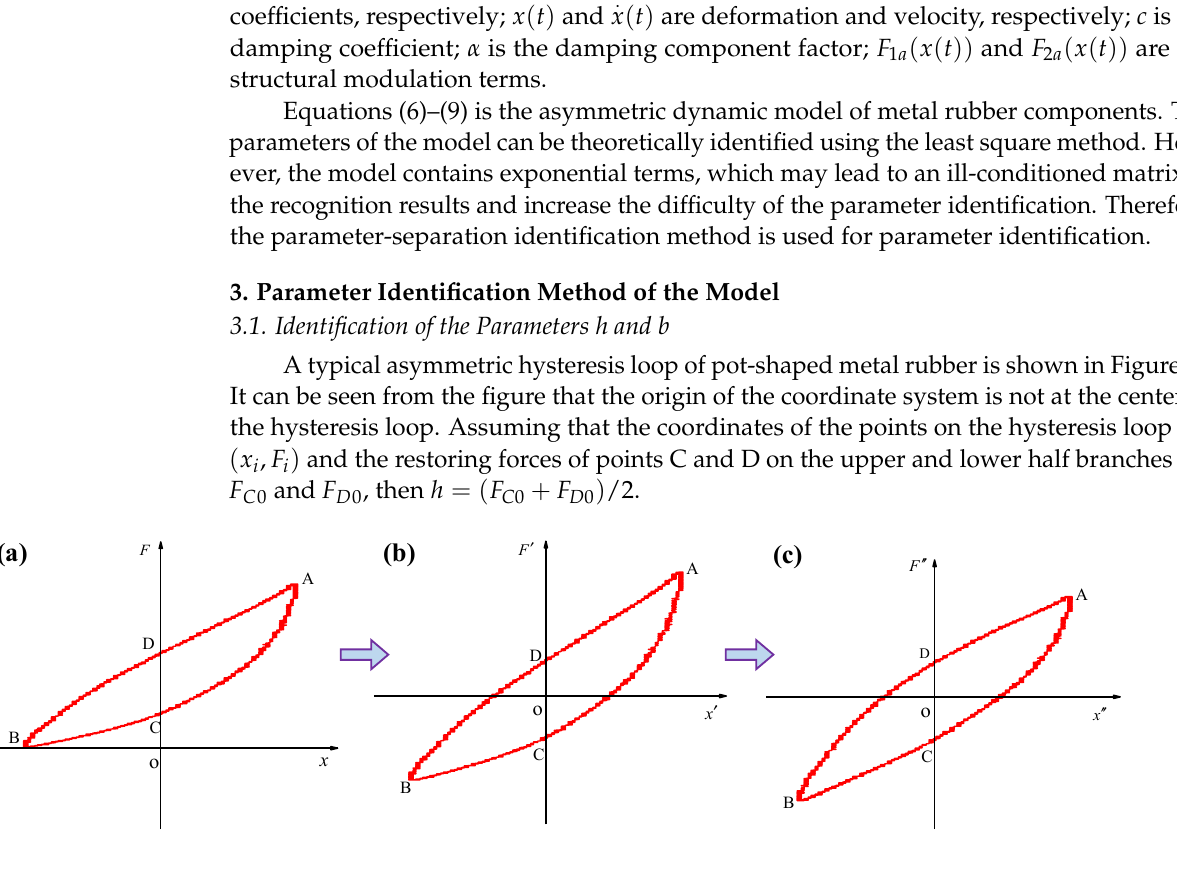
Figure 1. Hysteresis loops of pot-shaped metal rubber: ( a ) asymmetric hysteresis loop; ( b ) after the first transformation; ( c ) after the second